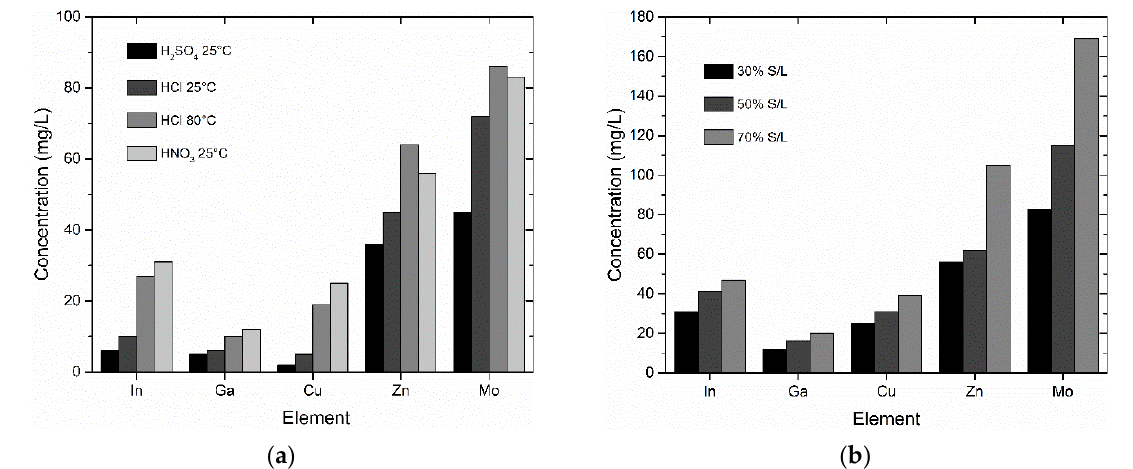
Figure 3. Effect of ( a ) different acids and ( b ) different S/L ratios on the extraction of metals. Table 2. Thin film-coated glass fragment leachate.